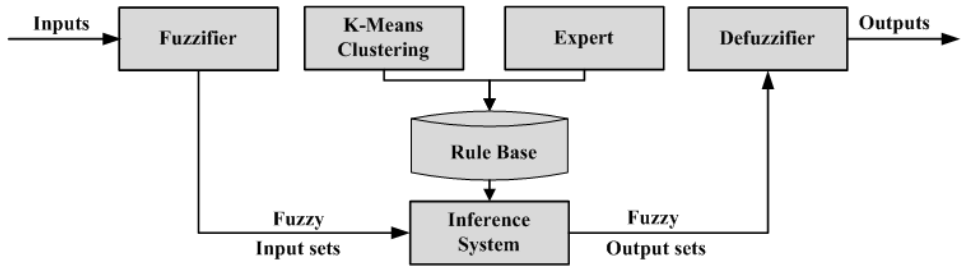
Figure 5. Diagram of a fuzzy inference system.